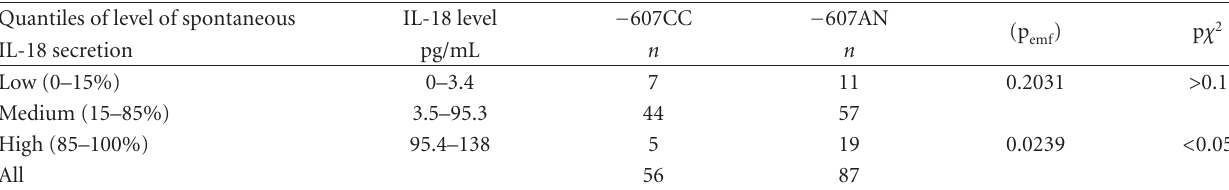
Table 1: Distribution of frequencies of IL-18 gene promoter genotypes at the − 607 A → C position in relation to the level of spontaneous IL-18 secretion.